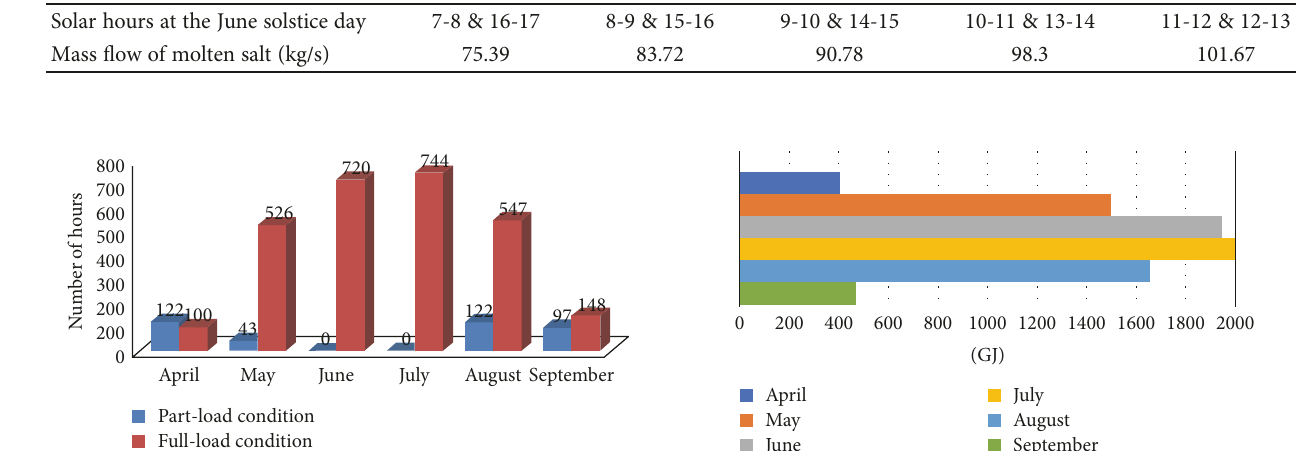
Table 3: Mass fl ows of molten salt at various hours at the June solstice day.